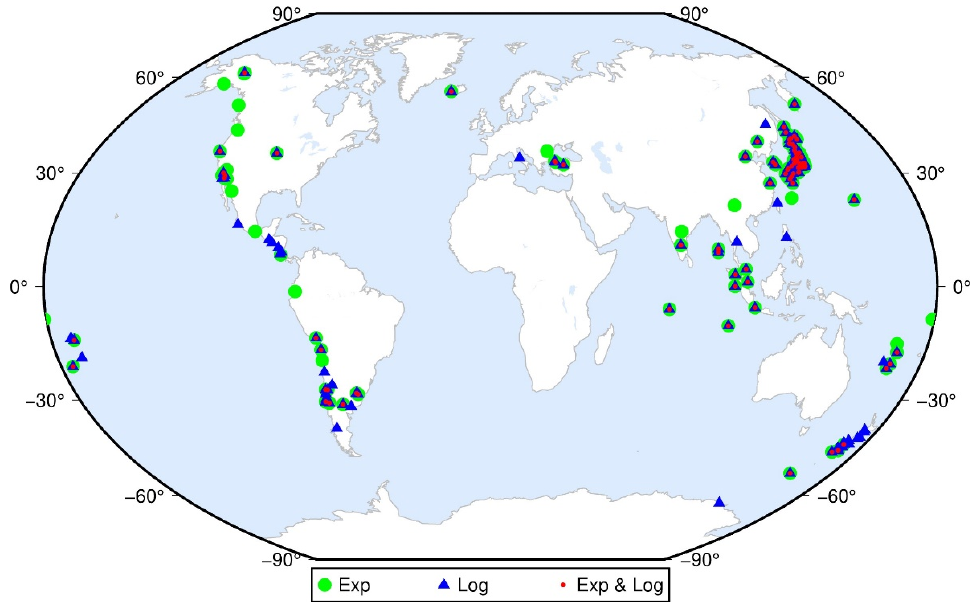
Figure 14. The sites’ impacted seismic deformation with different PSD combination patterns.